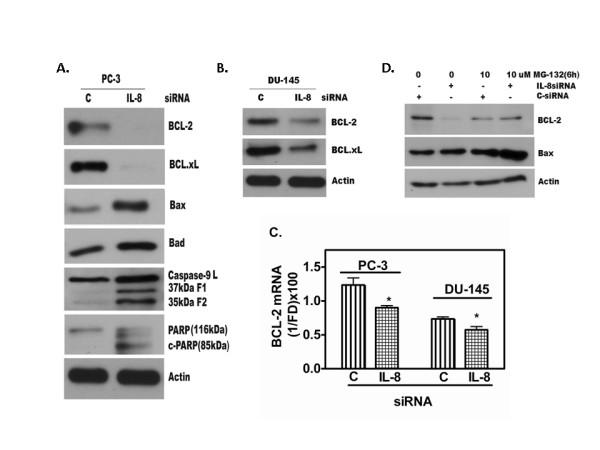
IL-8 depletion causes decrease in anti-apoptotic proteins and increase in pro-apoptotic proteins in AIPC cells. A. Depletion of IL-8 in PC-3 and (B) DU145 cells caused increased spontaneous apoptosis detected by caspase-9 activation; cleaved caspase-9 fragments, both of and 37 kDa and 35 kDa along with 39 kDa latent caspase-9 and cleaved poly(ADP-ribose)polymerase (PARP) (85 kDa) proteins are shown. Levels of BCL-2, BCL-xL, BAX and BAD were detected by western blotting of cell lysates prepared 48 h after transfecting the cells with 50 nM IL-8 siRNA or C-siRNA. β-Actin level is shown to ascertain equal protein loading in all lanes. C. Decrease in BCL-2 level was due to decrease in mRNA level determined by Q-PCR. D. The decrease in BCL-2 and increase in BAX level may also be due to rapid degradation of BCL-2 protein that in turn resulted in increased level of BAX. Inhibition of proteasome degradation of BCL-2 by MG132 shows unchanged level of BCL-2 between C-siRNA transfected control and IL-8siRNA transfected cells (Lanes 3 and 4).